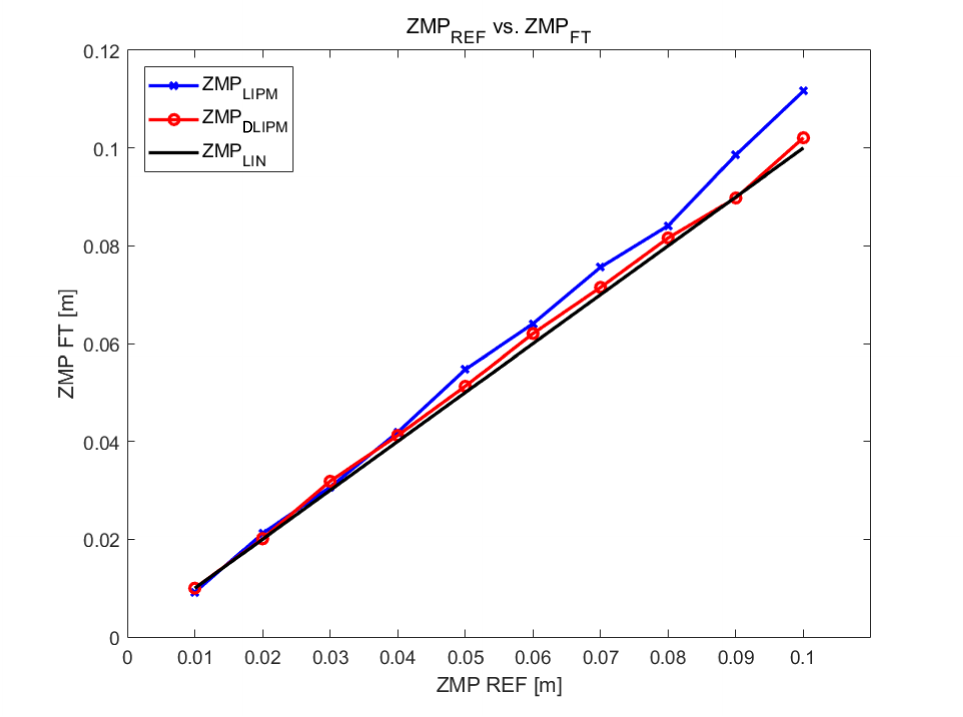
Figure 20. ZMP comparison using the LIPM and